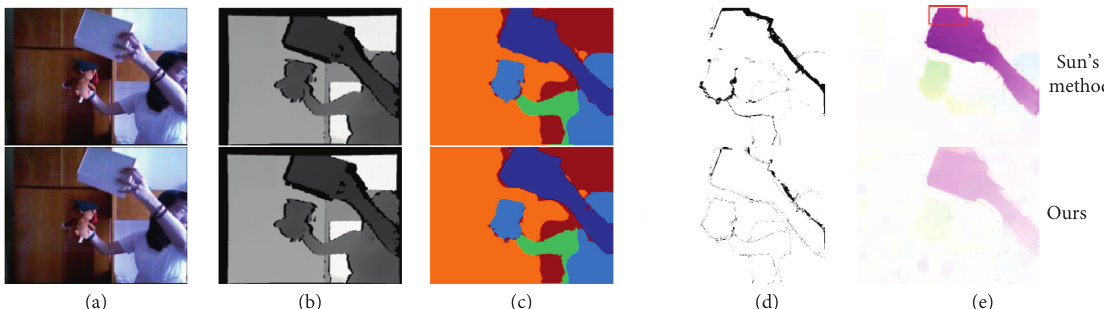
Figure 5: “Bear_back” sequence test results. Two consecutive frames from “Bear_back” sequence are input and segmented into 5 regions to estimate occlusion and scene flow. (a) RGB images. (b) Depth images. (c) Segmentation K � 5. (d) Occlusions. (e) Motion.